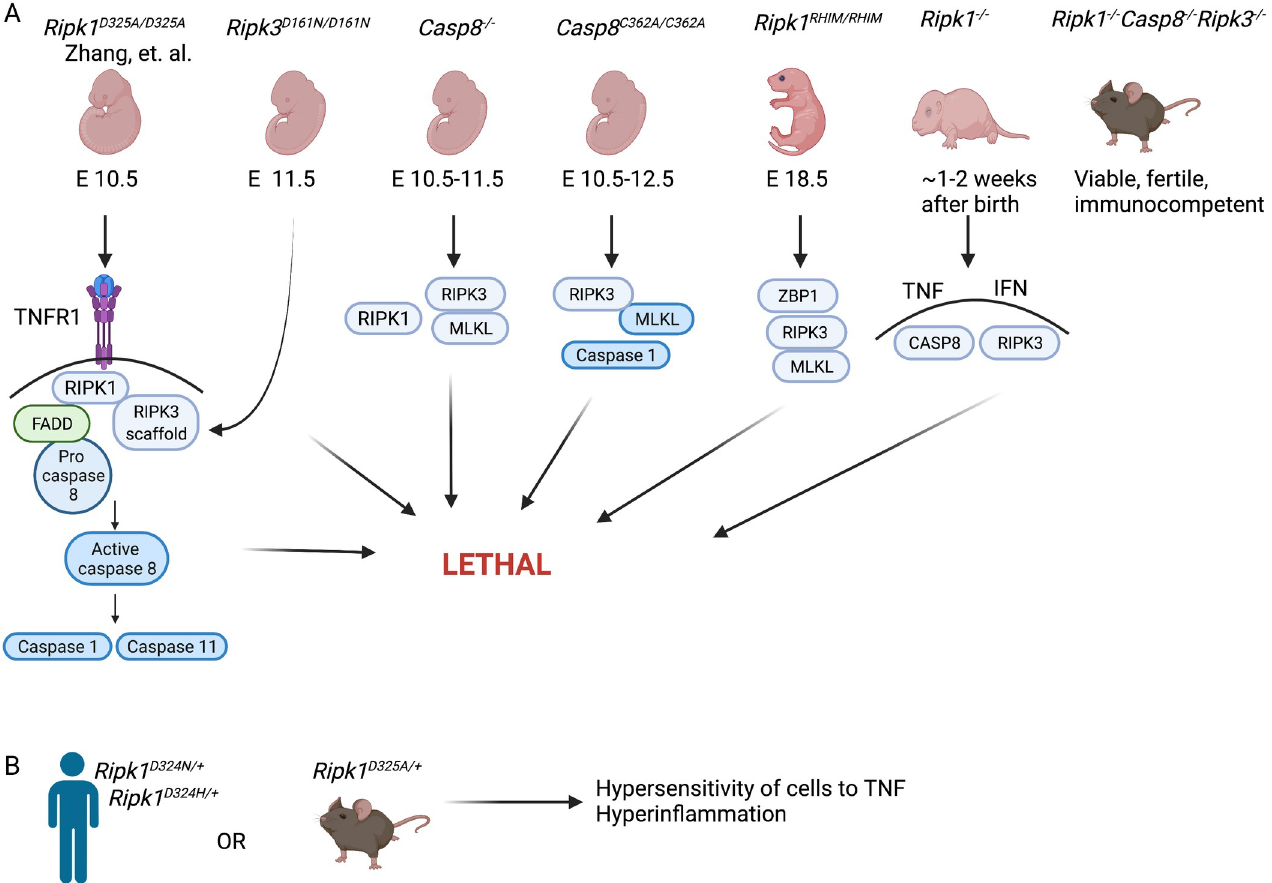
Fig 1. RIPK1 dictates cell fate and inflammatory outcome by restricting cell death components. (A) Summary of consequences with indicated mutations introduced in RIPK1 as described by Zhang and colleagues and others [1–3,5–9],RIPK3 [10], and CASP8 [5–7] genes. Genetic requirements for execution of lethality are indicated for each condition. (B) Outcome of heterozygous cleavage-resistant RIPK1 alleles [5–7]. Original images created with the assistance of BioRender.com. C AU : AnabbreviationlisthasbeencompiledforthoseusedthroughoutFig 1 : Pleaseverifythatallentriesarecorrect : ASP8, caspase-8; E10.5, embryonic day 10.5; E11.5, embryonic day 11.5; E12.5, embryonic day 12.5; E18.5, embryonic day 18.5; FADD, Fas- associated death domain protein; IFN, interferon; MLKL, mixed lineage kinase domain-like; RIP, receptor-interacting protein; RIPK, receptor-interacting protein kinase; TNF, tumor necrosis factor; TNFR, tumor necrosis factor receptor; ZBP, Z-nucleic acid binding protein.